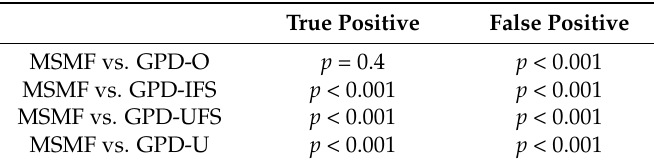
Table 3. Comparison of true positive and false positive strides between the MSMF and GPD algorithms (paired sample t-test).